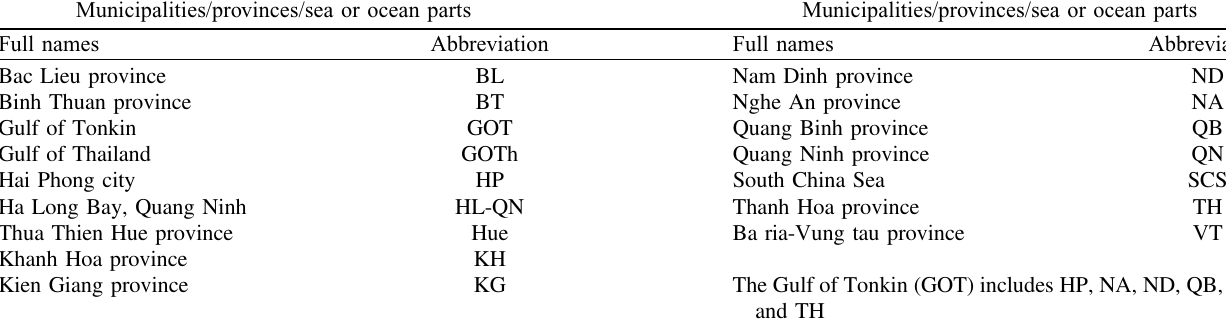
Table 1. The abbreviated names of the municipalities, provinces, and sea or ocean parts where samples were collected. Municipalities/provinces/sea or ocean